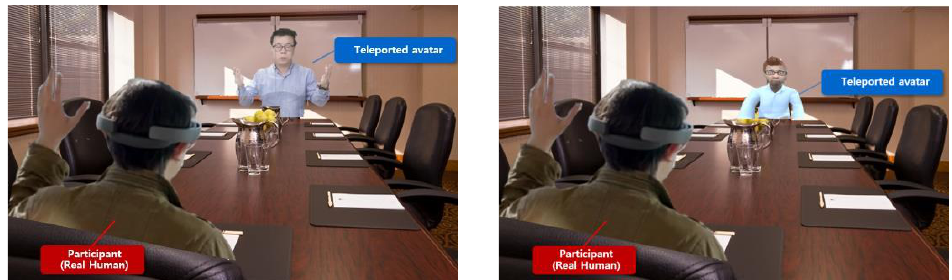
Figure 1. 3D MR tele-conference system to collaborate at a local site with a teleported avatar of the remote participant. The MR tele-conference system can make various typed teleported avatars; for example, a realistic avatar capturing the remote participant ( left ), and a pre-built character-like avatar using a 3D modeling toolkit ( right ).